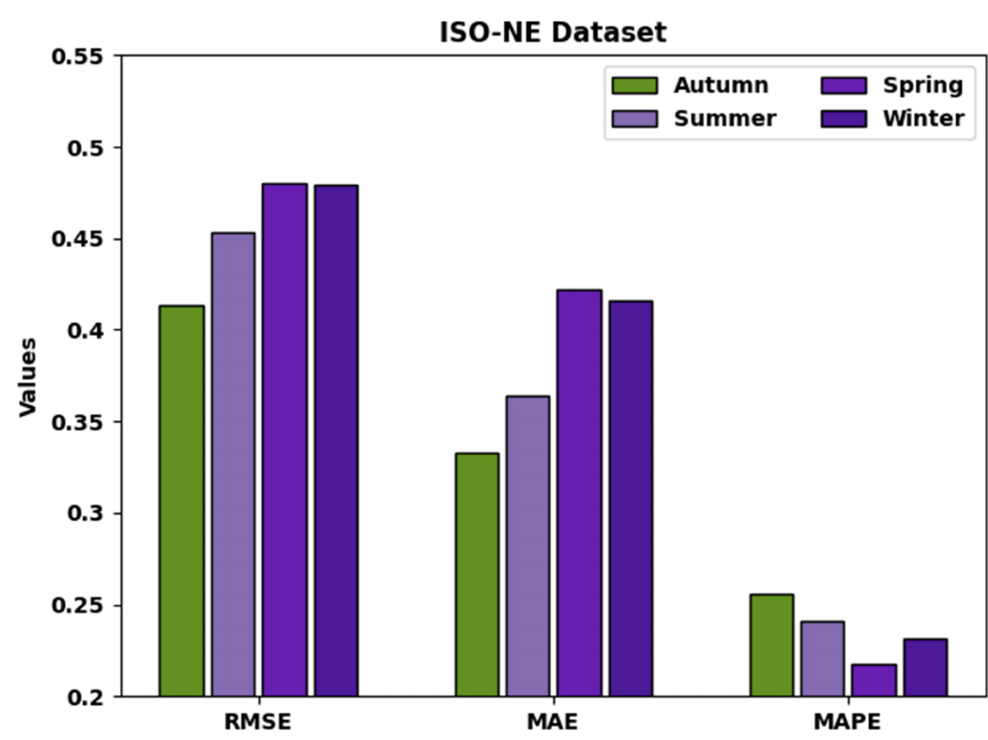
Figure 5. Result analysis of AJODL-DSSEM technique under ISO-NE